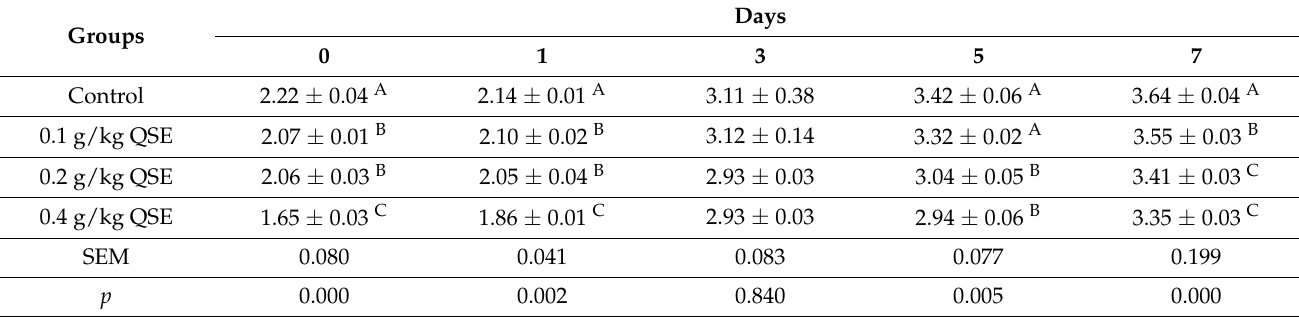
Table 11. Total number of psychrophilic bacteria in breast meat (log